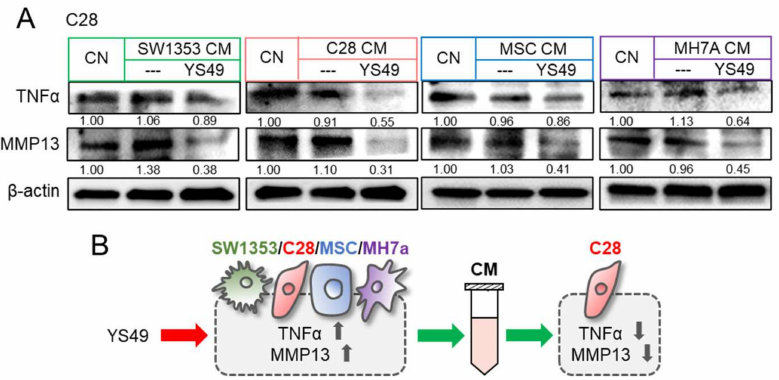
Figure 4. Reduction in TNF α and MMP13 by YS49 CM. CN = control, CM = conditioned medium, YS = YS49, SW = SW1353 CS cells, C28 = C28/I2 chondrocytes, and MH7a = MH7a synovial cells. ( A ) Downregulation of TNF α and MMP13 in C28/I2 chondrocytes by YS49-treated SW1353 CS cell, C28 chondrocyte, MSC, and MH7a synovial cell-derived CMs, respectively. The concentration of YS49 was 50 µ M. ( B ) Schematic diagram for the effects of YS49 and YS49 treated cells-derived conditioned medium. Full Western blot images are available in Figure